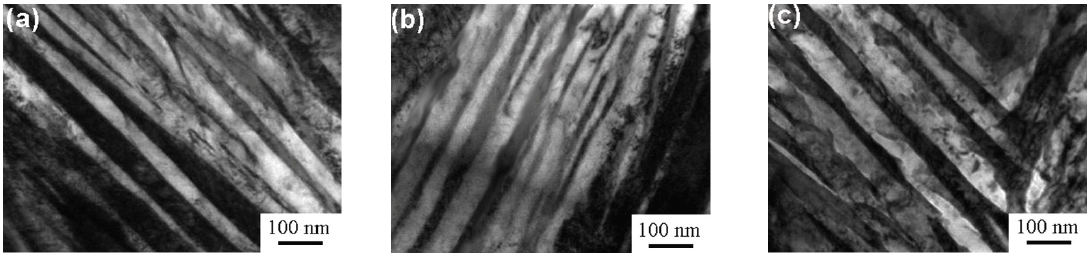
Figure 3. TEM micrographs of isothermally-transformed samples. ( a ) A1; ( b ) A2; ( c ) A3. Table 1. Mechanical properties of isothermally-transformed samples.